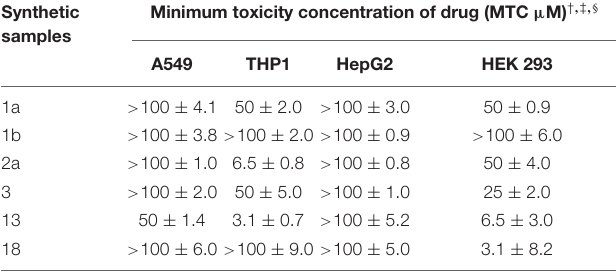
TABLE 3 | Toxicity of synthetic compounds to cell lines. Synthetic samples